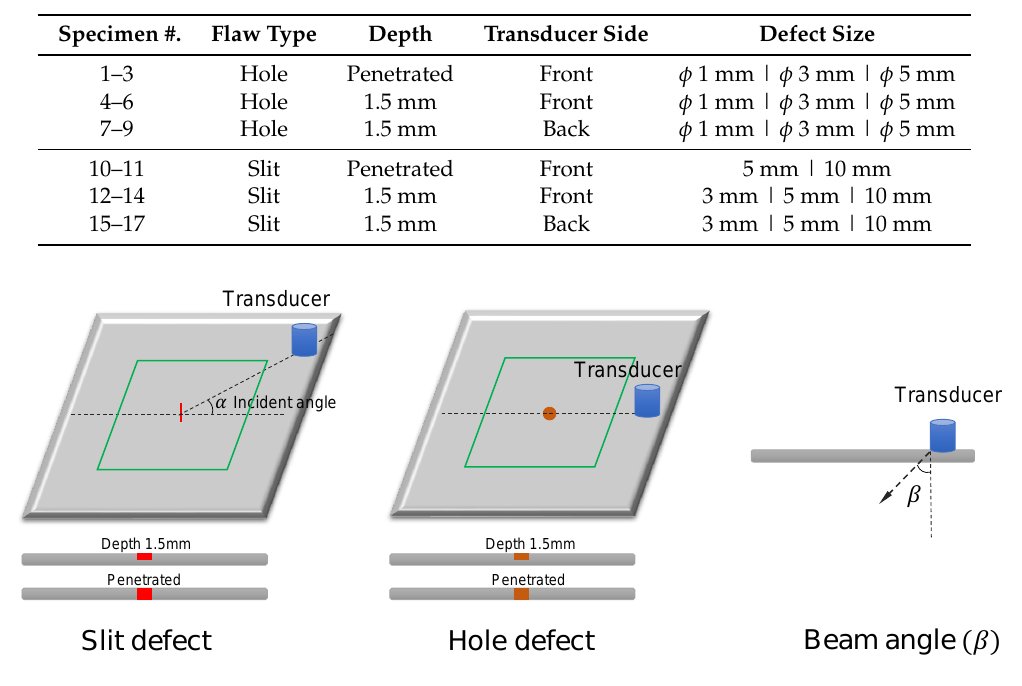
Figure 6. Sample patches from the dataset, including the ones with defects ( left ) and no defects ( right